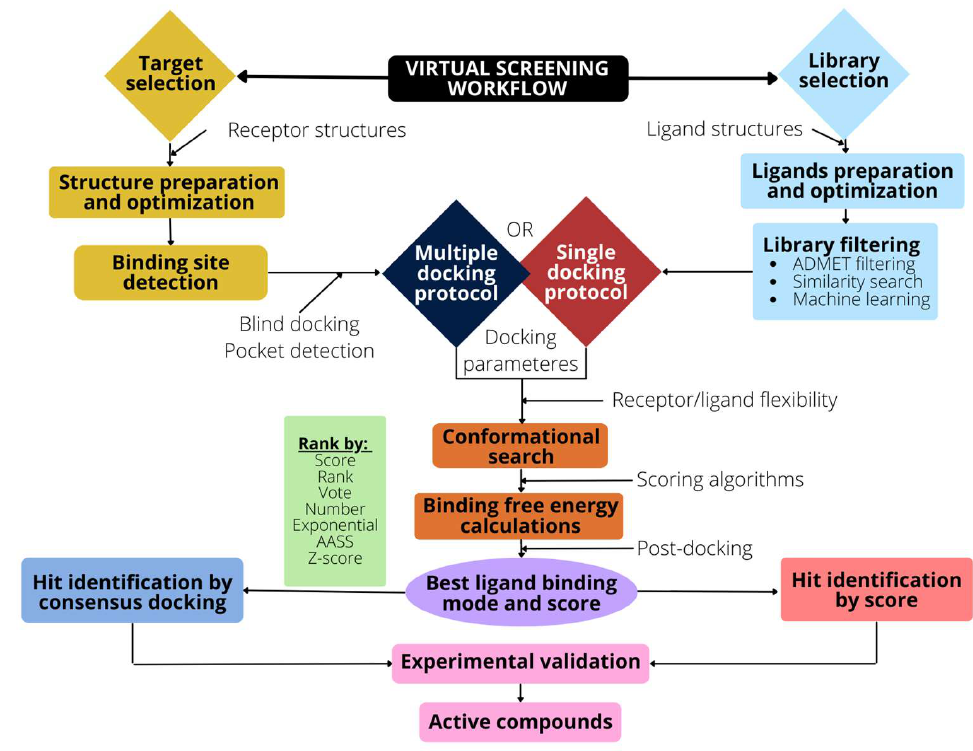
Figure 3. Schematic representation of the VS workflow. The selection and optimization of the target (receptor) is followed by the binding pocket detection and the preparation of the docking input files. Library selection requires optimization and preparation to filter undesired ligands. An ADMET filtering or similarity search can also be used to reduce the ligand space. Docking algorithms are then improves the VS method’s